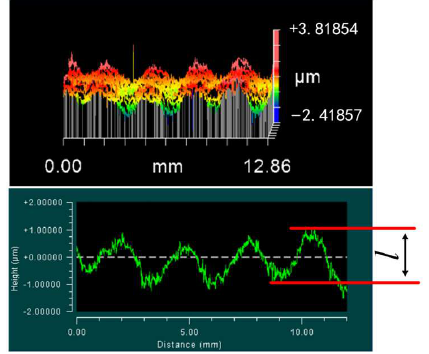
Figure 5. Typical image of surface morphology after grinding.